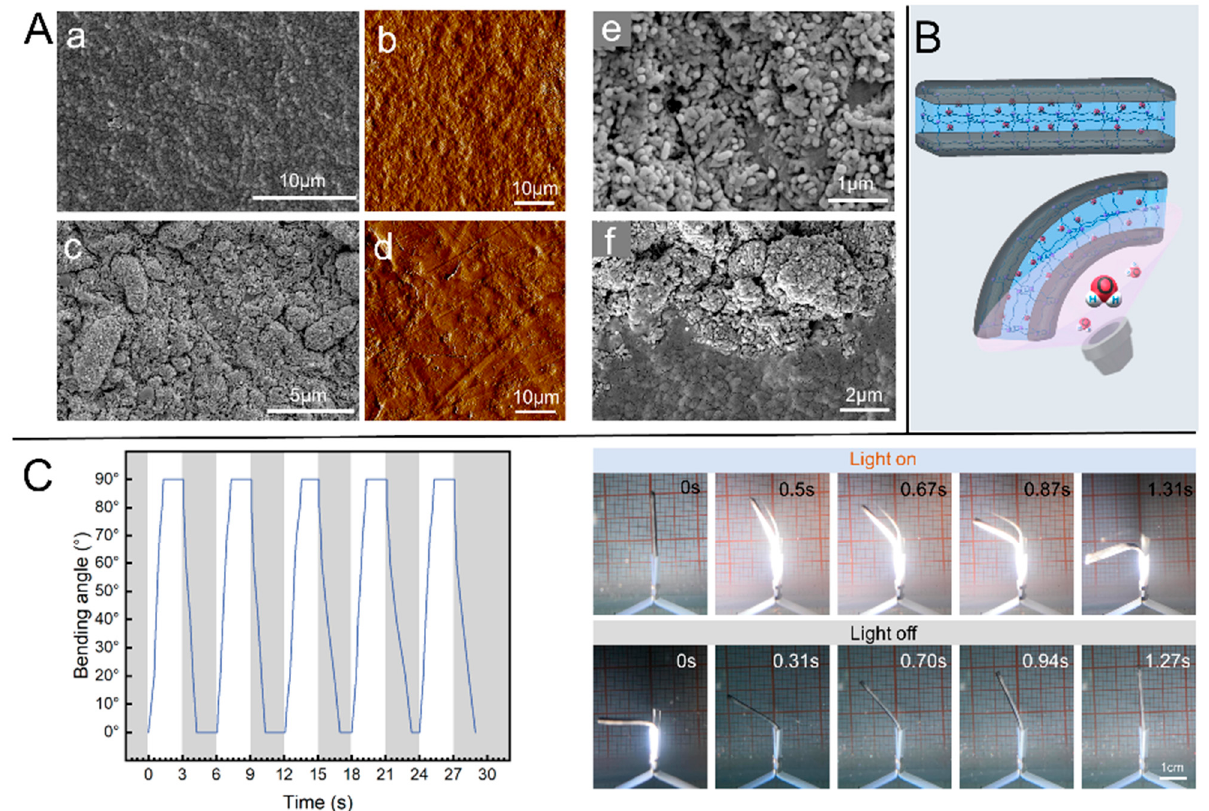
Figure 2. ( A ) Characterization of the hydrogel structure. ( a , c ) SEM photographs without and with CNTs, respectively, and ( b , d ) AFM photographs without and with CNTs, respectively. ( e ) A high- resolution SEM photograph of the surface of the hydrogel with CNTs. ( f ) A side SEM photograph of the hydrogel. ( B ) Schematic diagram of the light-driven deformation principle of composite hydrogel. ( C ) Light-controlled bending deformation performance.